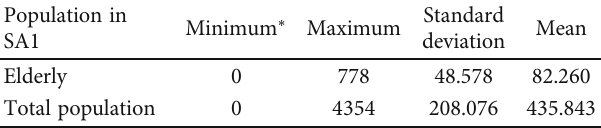
Table 4: Population summary of metropolitan Melbourne